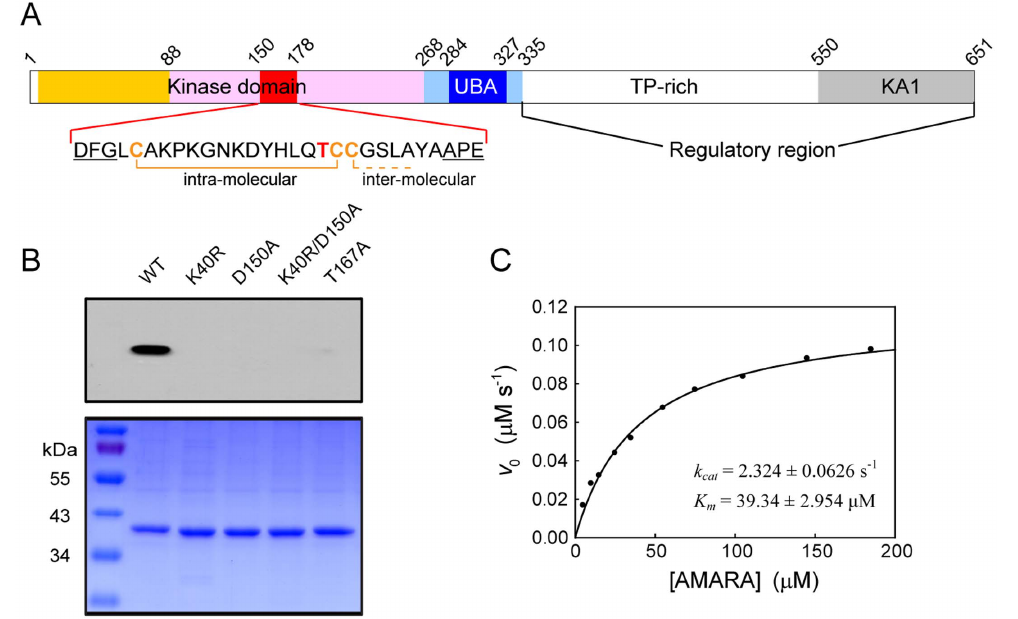
Figure 1. Autophosphorylation of MELK KD-UBA. (A) Schematic diagram of MELK. The domains are colored as follows: kinase domain (N-lobe, orange; C-lobe, pink), UBA domain (blue), linker regions flanking UBA (slate blue) and KA1 domain (gray). The sequence of the activation segment (red) is provided, with the Thr residue required for kinase activity and the Cys residues involved in the formation of the disulfide bonds highlighted in bold. Residue numbers refer to human MELK (Swiss-Prot entry Q14680). (B) Phosphorylation state of Thr167 in the activation segment. Upper row: broad-spectrum phospho-Thr antibody detection; lower row: Coomassie blue staining. (C) Dependence of the initial velocity of the MELK KD-UBA- catalyzed reaction on the concentration of the AMARA peptide. The assays were carried out in a standard buffer containing 50 nM wildtype MELK KD- UBA, 10 mM DTT and the indicated amounts of AMARA. The solid line represents the best fit to the Michaelis-Menten equation with k cat and K m values of 2.324 6 0.0626 s 2 1 and 39.34 6 2.954 m M, respectively.